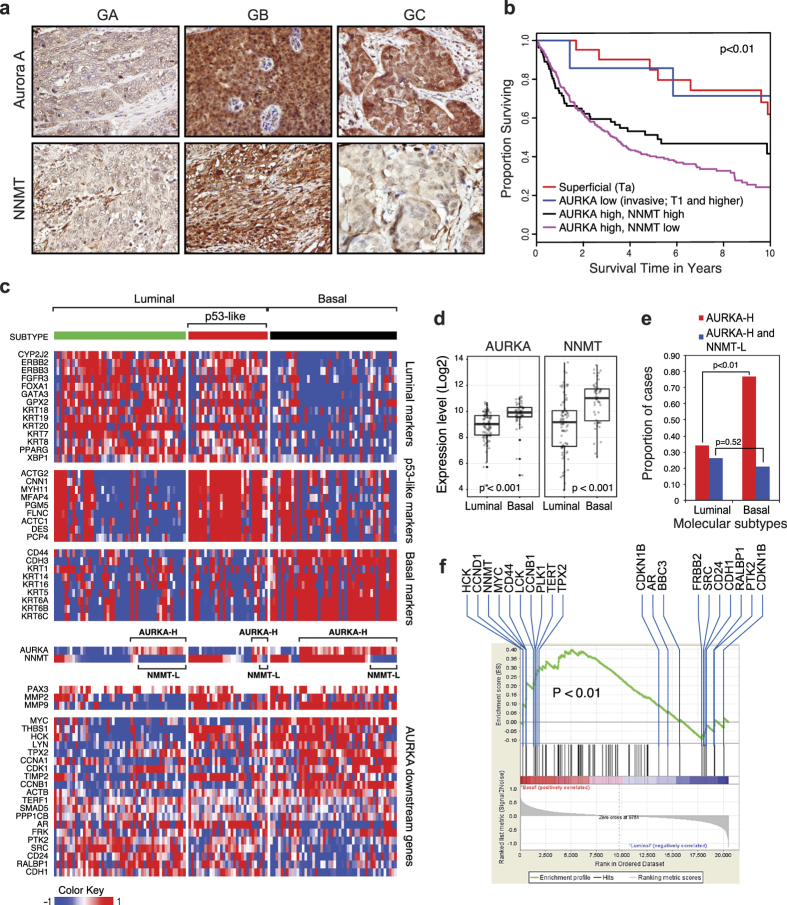
Overexpression of AURKA and down-regulation of NNMT defines aggressive variant of bladder cancer.(a) Expression levels of Aurora A and NNMT genes revealed by immunohistochemical staining in selected tumor samples from tissue microarray showing three paired patterns characteristic for three groups of invasive (T1 and higher) bladder cancer: GA (AURKA and NNMT with low expression), GB (AURKA and NNMT with high expression) and GC (AURKA with high expression and NNMT with low expression). (b) Kaplan-Meier analyses of disease-specific survivals in four groups of samples. Superficial (Ta) tumors were separated from invasive (T1 and higher). The invasive tumors were divided into three groups corresponding to samples with (1) low levels of AURKA expression (AURKA-L); (2) high levels of AURKA (AURKA-H), and high levels of NNMT (NNMT-H); and (3) high levels of AURKA (AURKA-H) and low levels of NNMT (NNMT-L). (c) Expression pattern of AURKA and AURKA signature genes in molecular subtypes of bladder cancer in the TCGA bladder cancer cohort comprising 128 high-grade muscle invasive bladder tumor samples which were classified into luminal, p53-like, and basal subtypes using the previously published algorithm. Subsets of samples with high levels of AURKA (AURKA-H) as well as subsets of samples showing overexpression of AURKA (AURKA-H) with downregulation of NNMT in molecular subtypes are shown. (d) Expression levels of AURKA and NNMT in luminal and basal subtypes of bladder cancer. (e) Proportions of cases with overexpression of AURKA (AURORA-H) and proportions of cases which show overexpression of AURKA (AURKA-H) with downregulation of NNMT (NNMT-L) in luminal and basal subtypes of bladder cancer. (f) Enrichment of AURKA downstream regulatory pathways in basal as compared to luminal subtypes of bladder cancer revealed by GSEA.